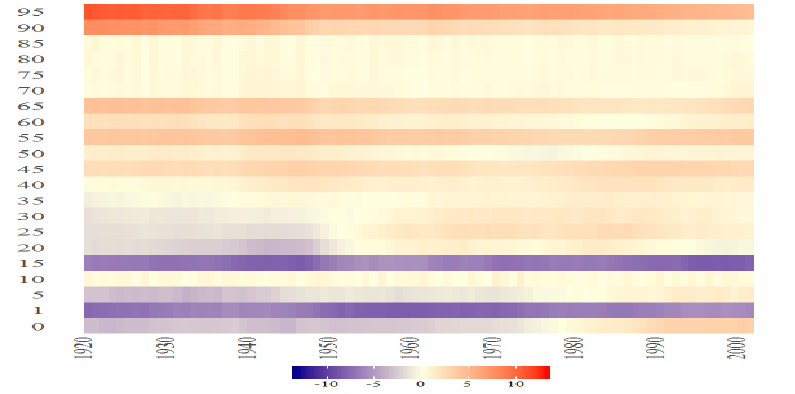
Figure 33. The Bayesian posterior mean estimates for (cid:36) t across age groups (y axis) over time (x axis) under DFM-PC-B model for British female log death rates during 1922–2002.